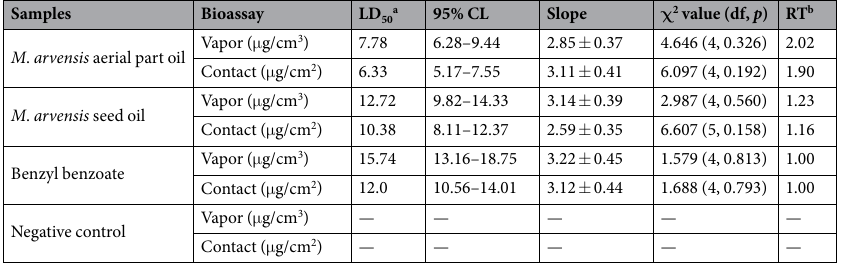
Table 1. Acaricidal toxicities of M . arvensis aerial part oil, M . arvensis seed oil, and synthetic acaricide against T . putrescentiae ( a LD 50 is the average of 5 determinations, with 30 adult mites per replication; Exposed for 24